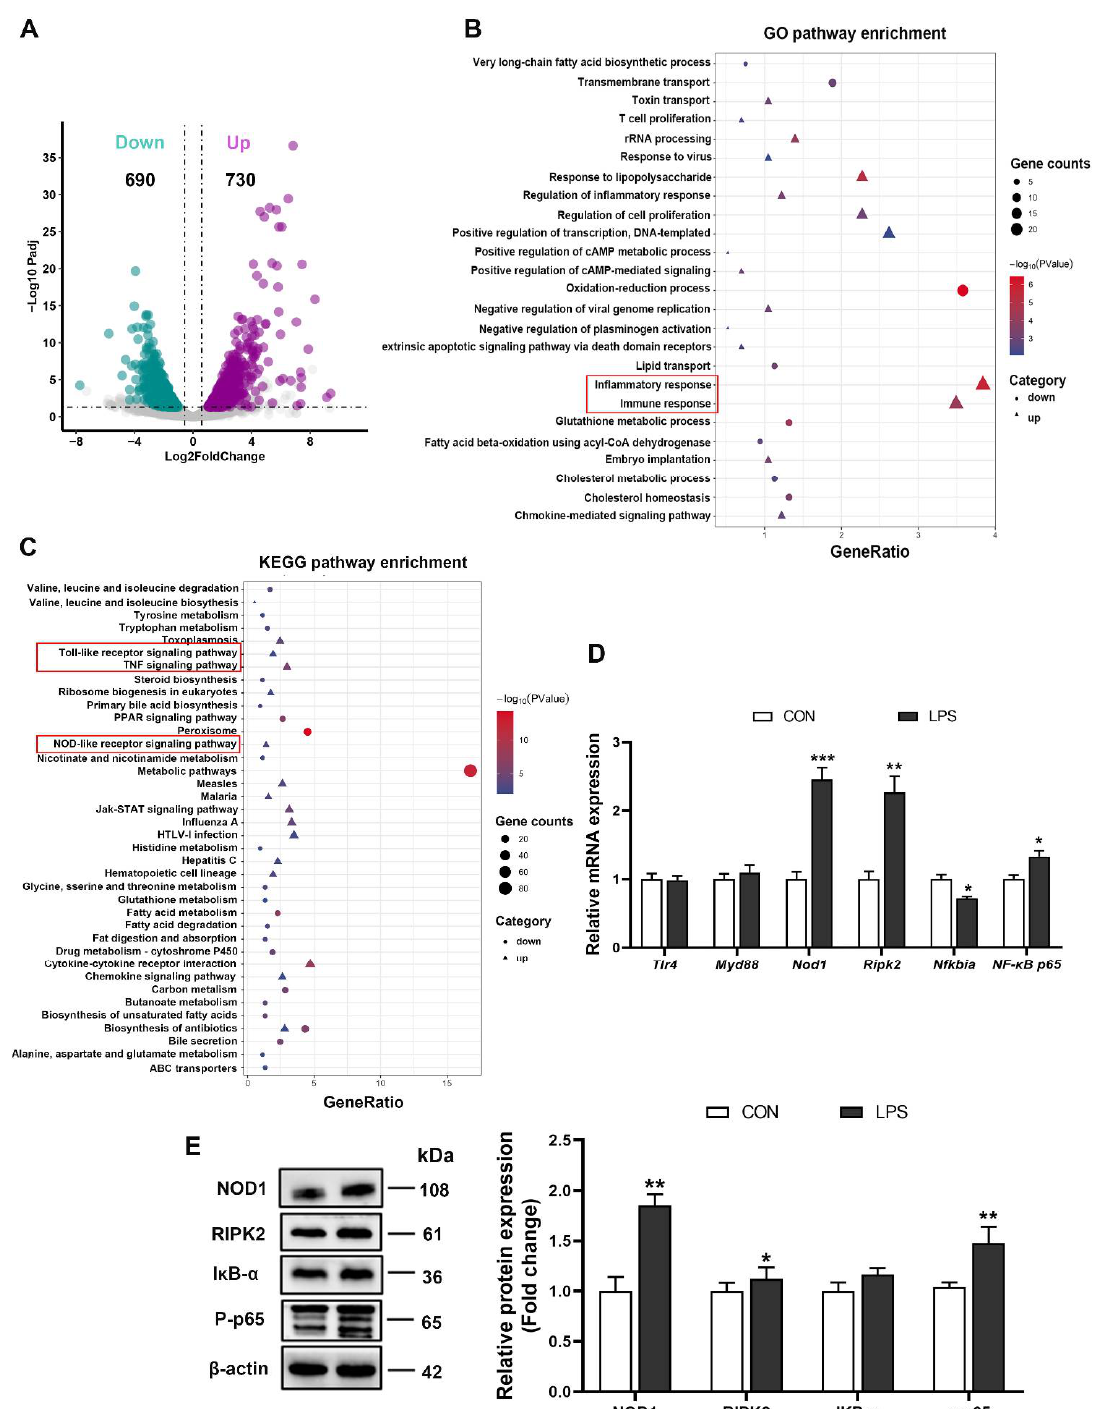
Figure 2. The NOD1/NF- κ B signaling pathway was activated in the liver of piglets challenged with LPS. ( A ) Volcano plots of comparative RNA-seq data between the CON group and the LPS group. ( B ) GO analysis based on the RNA-seq in the biological process of differential transcripts. ( C ) Representative KEGG analysis with the transcript corresponding to different genes. ( D ) The mRNA levels of TLR4, MyD88, NOD1, RIPK2, NFKBIA, NF- κ B p65 were evaluated by RT-qPCR. ( E ) Hepatic protein levels of NOD1, RIPK2, I κ B- α , and P-p65 were assessed by western blot, quantified using ImageJ analysis, and normalized to β -actin. n = 4 − 6 per group. Results are showed as means with SEM represented by a vertical bar. * represents significant differences between the CON group and the LPS group; * p < 0.05, ** p < 0.01, *** p